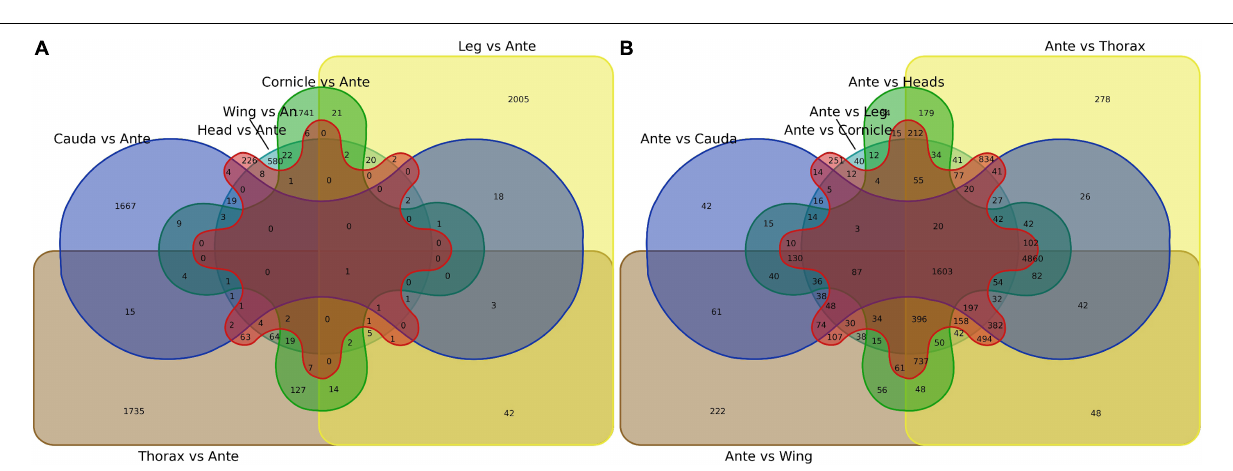
FIGURE 2 | Venn diagram of specially expressed transcripts between antennae and six other tissues (heads, legs, caudae, cornicles, thoraxes, and wings). (A) Specially expressed transcript numbers for six tissues compared with antennae. (B) Specially expressed transcript numbers for antennae compared with each of the other six tissues. An or Ante,